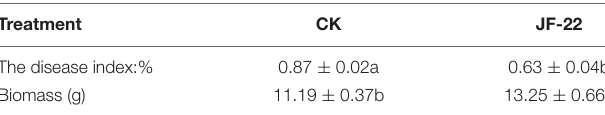
TABLE 3 | The GC–MS of major components in VOCs produced by JF-22 strain. Components